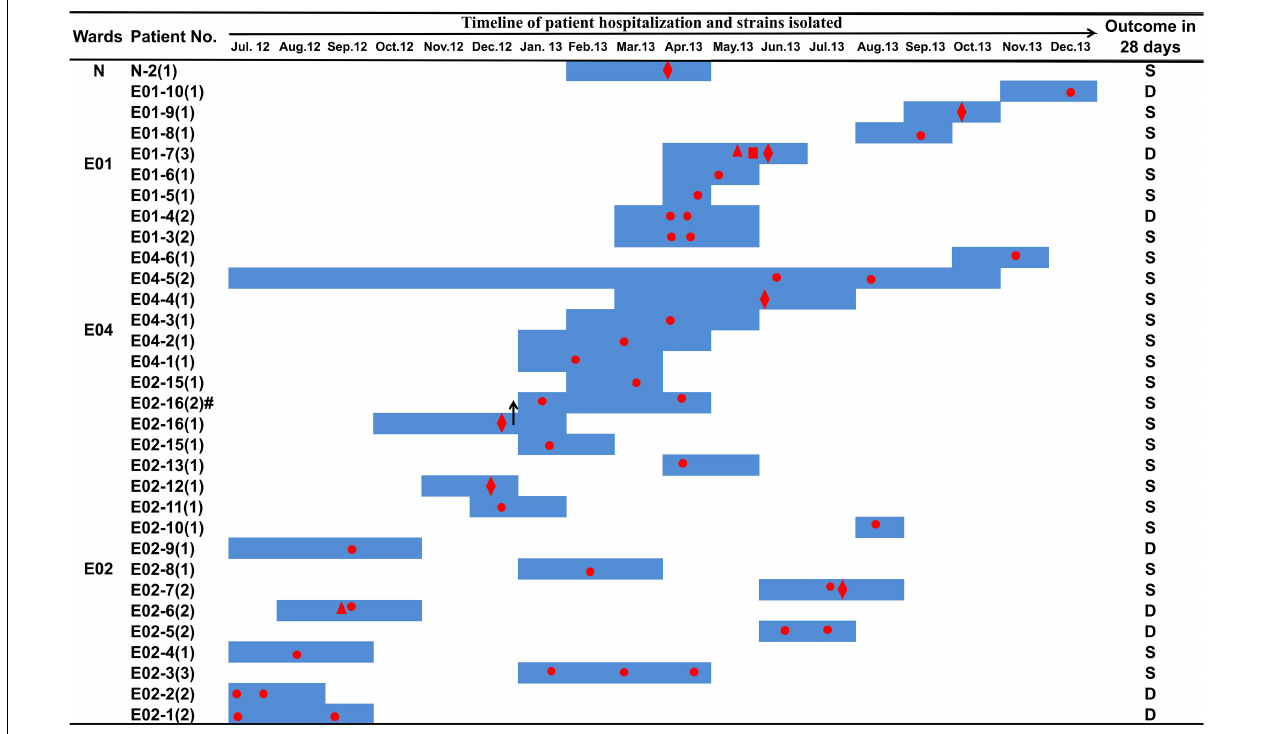
FIGURE 1 | Clinical features of patients from whom ST131 E. coli carrying bla KPC − 2 was isolated. Dark blue boxes indicate the period of hospitalization. Red dots indicate the time of bla KPC − 2 -positive E. coli isolation. The shapes of the red dots indicate the type of samples: circle, sputum or nasopharyngeal swab sample; diamond, urine; triangle, blood; square, drainage. The black arrows indicate a change of ward: patient number E02-16 was transferred from ward E02 to ward E04 on December 27, 2012. Abbreviations: D, death; S, survival.